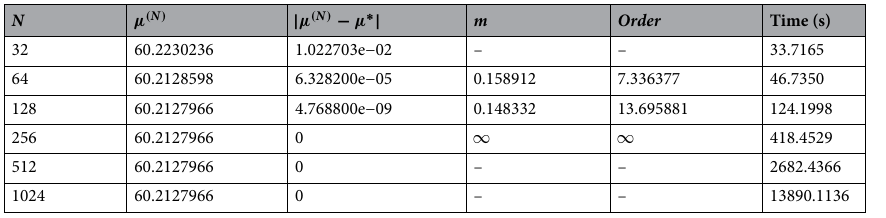
Table 2. The chemical potentials, the values of m and Order of the convergence rate and convergence order, respectively, and the execution time for 60.2127966 . µ ∗ =